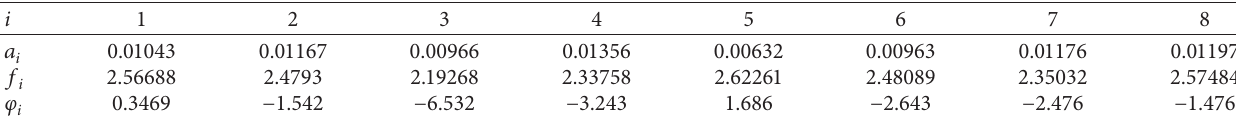
Table 6: Values of 24 fitting parameters in equation (1) in 100 ∼